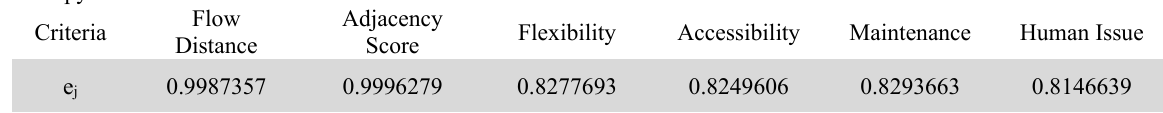
Entropy values Flow Adjacency Criteria Flexibility Accessibility Maintenance Distance Score e j Weight factor (w j ) for each criteria is determined by Eq. (8).